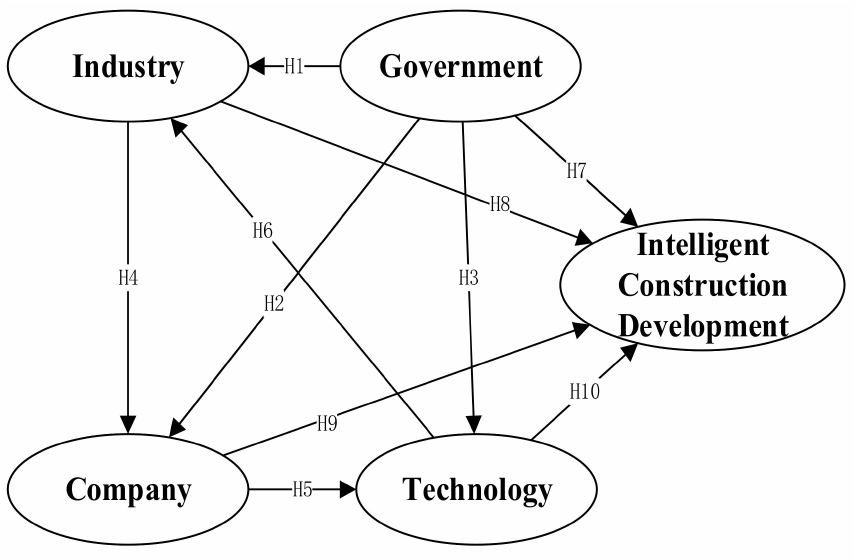
Figure 2. The conceptual model of the structural